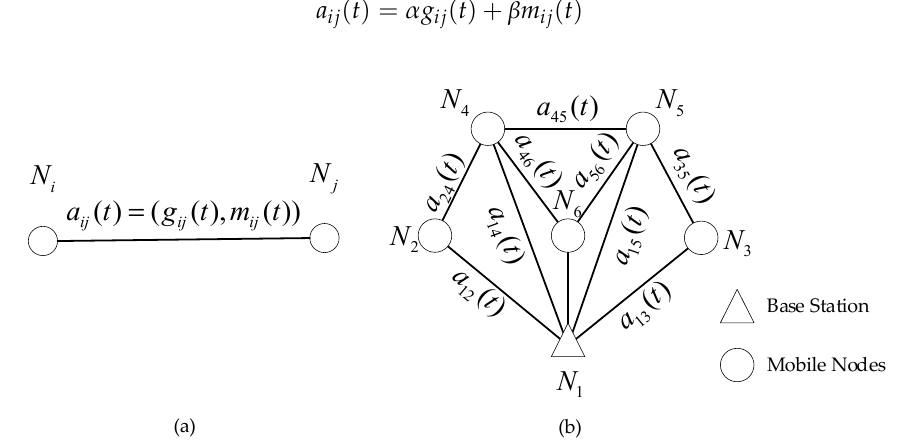
Figure 8. Network representation. ( a ) Graph of two nodes; ( b ) graph of six nodes (not all edges are shown in this picture).